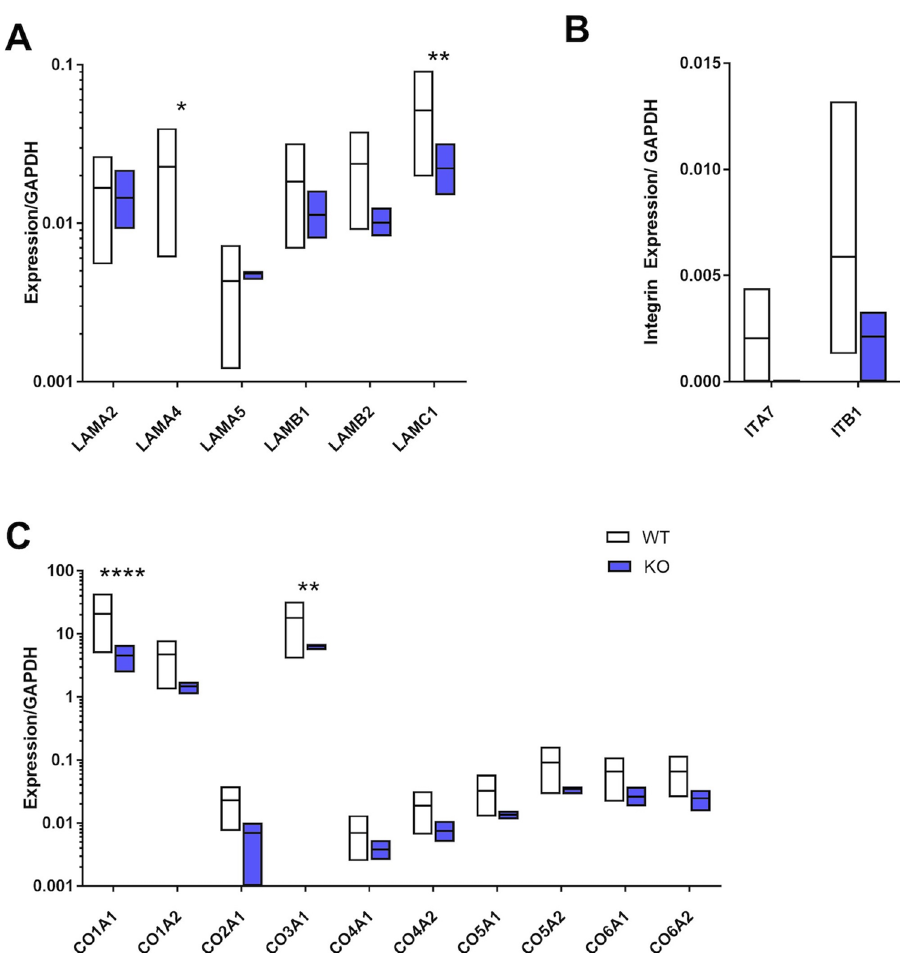
Figure 2. Matrix protein and integrin differences between subcutaneous adipose tissue from WT and KO mice. ( A ) In addition to the expected absence of laminin α4 in the adipose ECM, there was a significant decrease in laminin gamma 1 (LAMC1). ( B ) When evaluating proteins involved in cell binding and integrin signaling, integrins α7 (ITA7) and β1 (ITB1) were dramatically reduced in the subcutaneous adipose from KO mice. ( C ) Both collagen 1A1 (CO1A1) and collagen 3A1 (CO3A1) were significantly lower in subcutaneous adipose tissue from KO mice. n = 3 biological samples with 3 technical replicates. Data are presented as mean ± standard error of the mean with * p < 0.05, ** p < 0.01, **** p < 0.0001 as significant from one-way